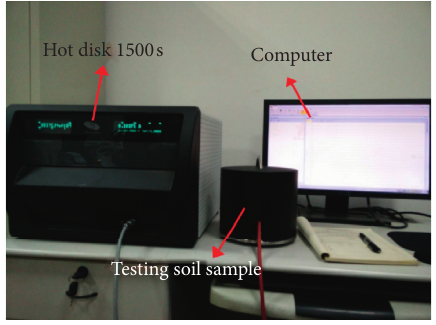
Figure 3: The thermal conductivity test